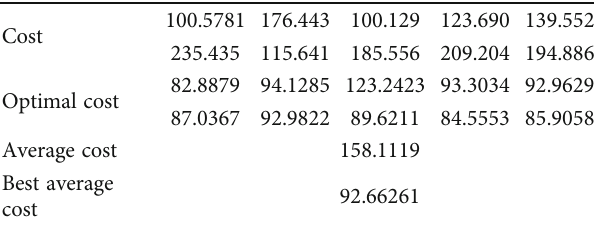
Table 6: Statistics of cost and optimal cost at di ff erent times.